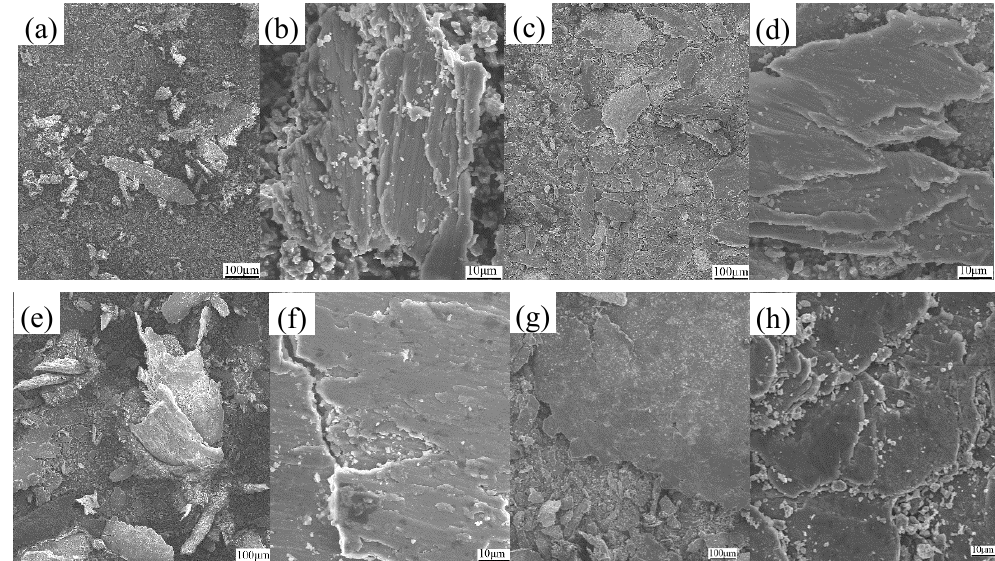
Figure 15. SEM images of the wear debris on 4.5 wt.% TiB 2 / 7075 specimens cast at 720 °C under different frictional loads: ( a,b ) 30 N, ( c,d ) 60 N, ( e,f ) 90 N, and ( g,h ) 120 N.